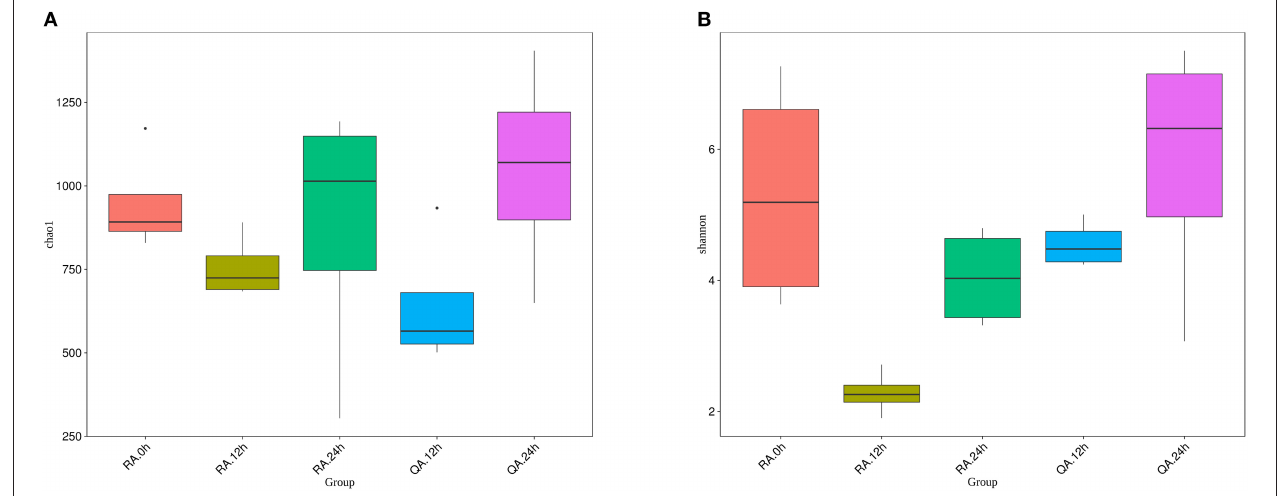
FIGURE 6 | The diversity of intestinal flora of tilapia, which fed with YM001 or HN016, changed differently. (A) Diversity of bacterial species as indicated by Chao1 rarefaction measure. The larger the number of OTU in the sample is, the larger the number of species in the sample. (B) Shannon index. The richness and evenness of the species composition in the sample were evaluated. The larger the value was, the more abundant the species was, and the more homogeneous the species were. Evenness based on species-level operational taxonomic units (OTUs). Error bars indicate SD,* indicates significant association (0.005 < P <